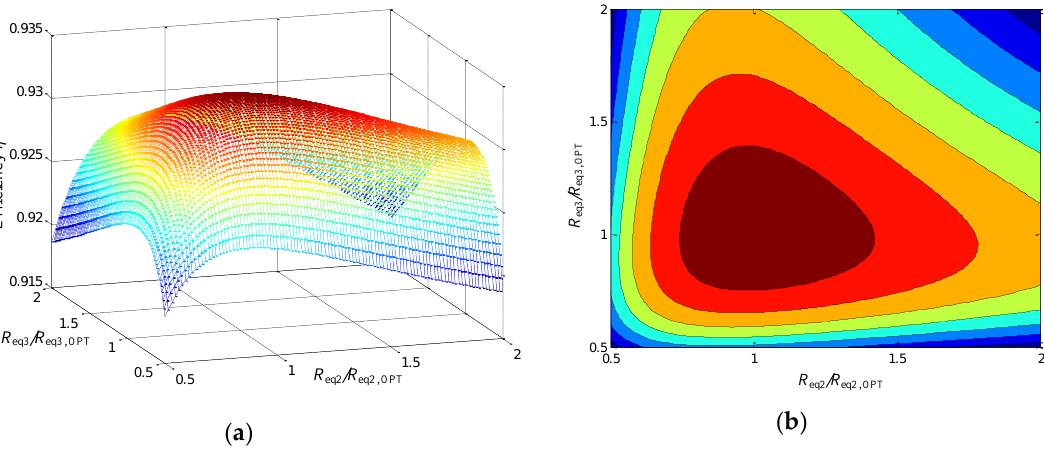
Figure 3. Efficiency versus resistance ratio at fixed mutual inductance: ( a ) efficiency versus R eq i / R eq i , OPT ; ( b ) contour map of efficiency.